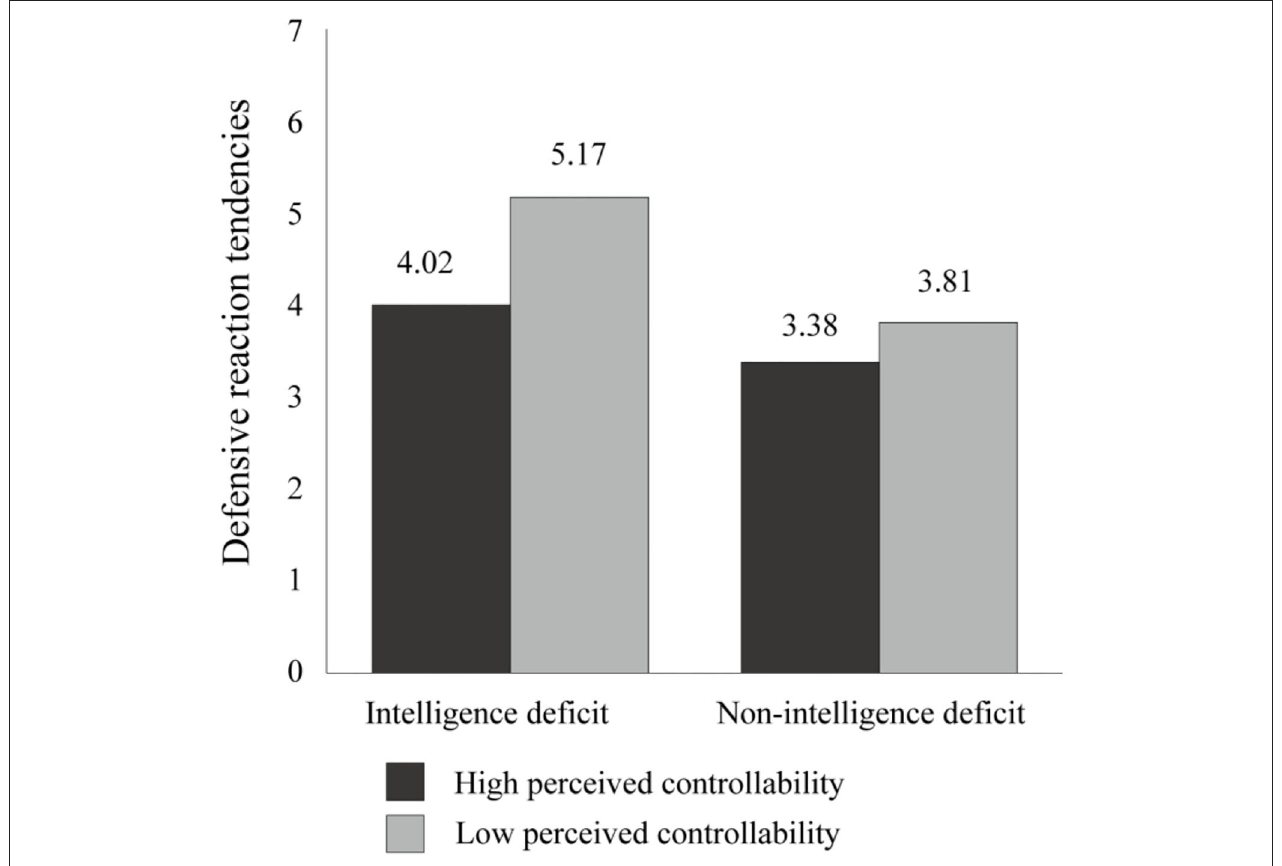
FIGURE 1 | Results of Experiment 1: defensive reaction tendencies, as a function of intelligence deficit and perceived controllability.